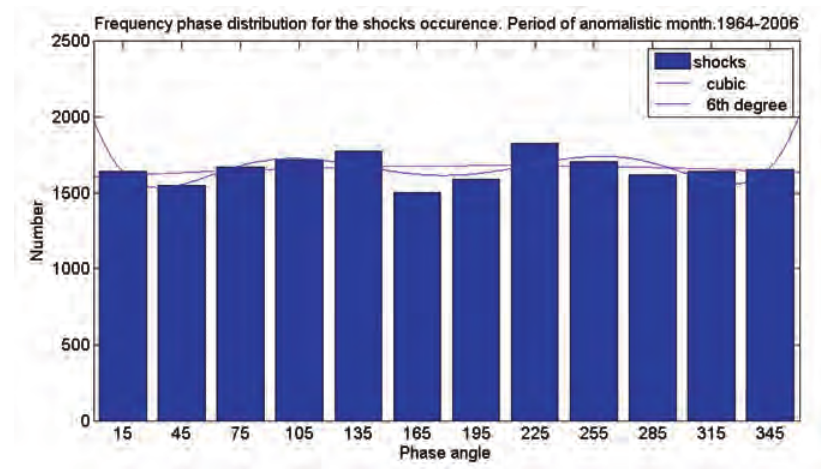
Figure 6. Cumulative histogram corresponding to the anomalistic month period, of all of the 19.916 events.